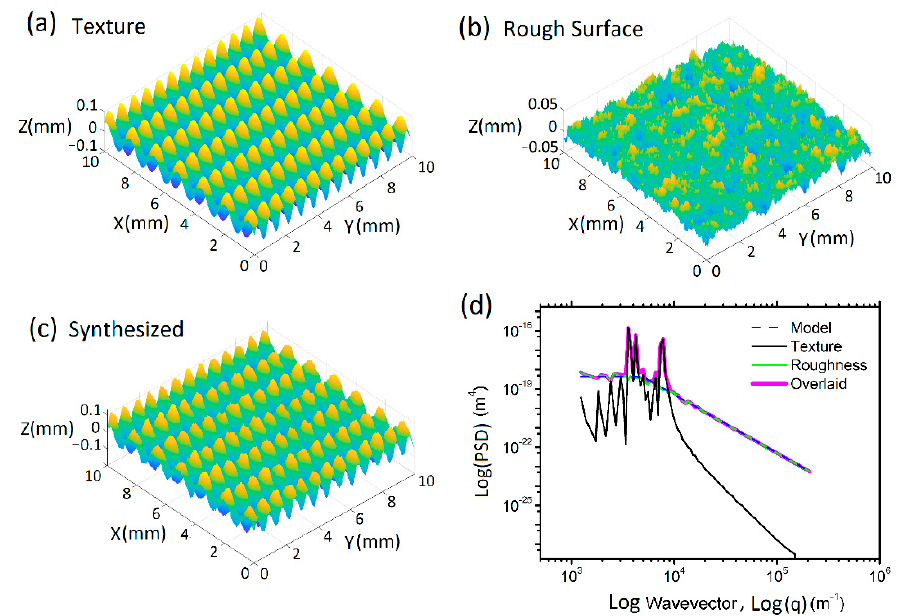
Figure 1. Example of PSD ( d ) for a textured surface ( c ) synthesized with a smooth texture ( a ) and a rough model ( b ). The smooth texture is 0.1 mm high; its wavelengths in X and Y directions are 1.58 mm and 0.79 mm, respectively. The rough surface has RMS = 10 µ m, Hurst exponent H = 0.5, and surface resolution dx = 20 µ m. q r , q L and q s indicate roll-off, large and small wavelength cut- offs.